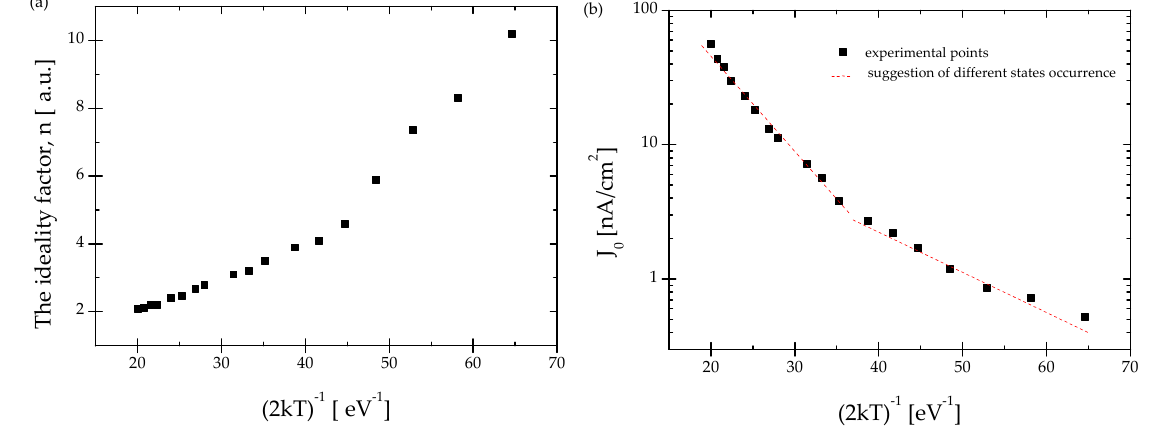
Figure 4. The temperature dependence of the experimental ( a ) ideality factor 𝑛 , and ( b ) the reverse saturation current of the diode for Au/p-PCD/n-Si/Au structure. The saturation current, J 0 ( T ) is given by the formula [26,28]: